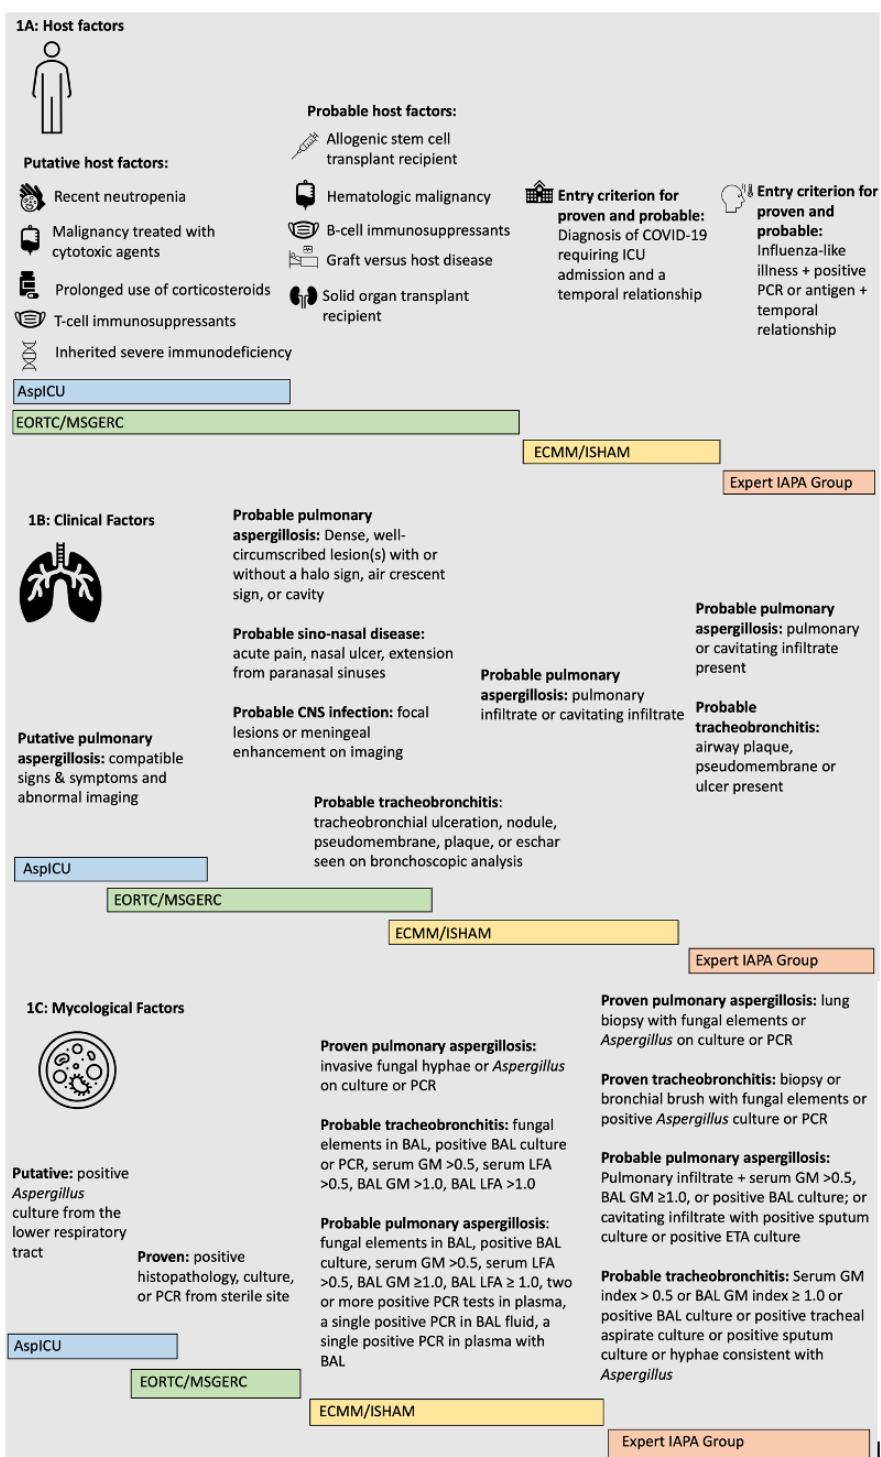
Figure 1. Case definitions of proven and probable CAPA and IAPA (1A: host factors; 1B: clinical factors; 1C mycological factors). CAPA: COVID-19-associated pulmonary aspergillosis; IAPA: influenza-associated pulmonary aspergillosis; EORTC/MSGERC: European Organization for Re- search and Treatment of Cancer/Invasive Fungal Infections Cooperative Group and the National Institute of Allergy and Infectious Diseases Mycoses Study Group; ECMM/ISHAM: European Con- federation for Medical Mycology and the International Society for Human and Animal Mycology; BAL: bronchoalveolar lavage; GM: galactomannan; PCR: polymerase chain